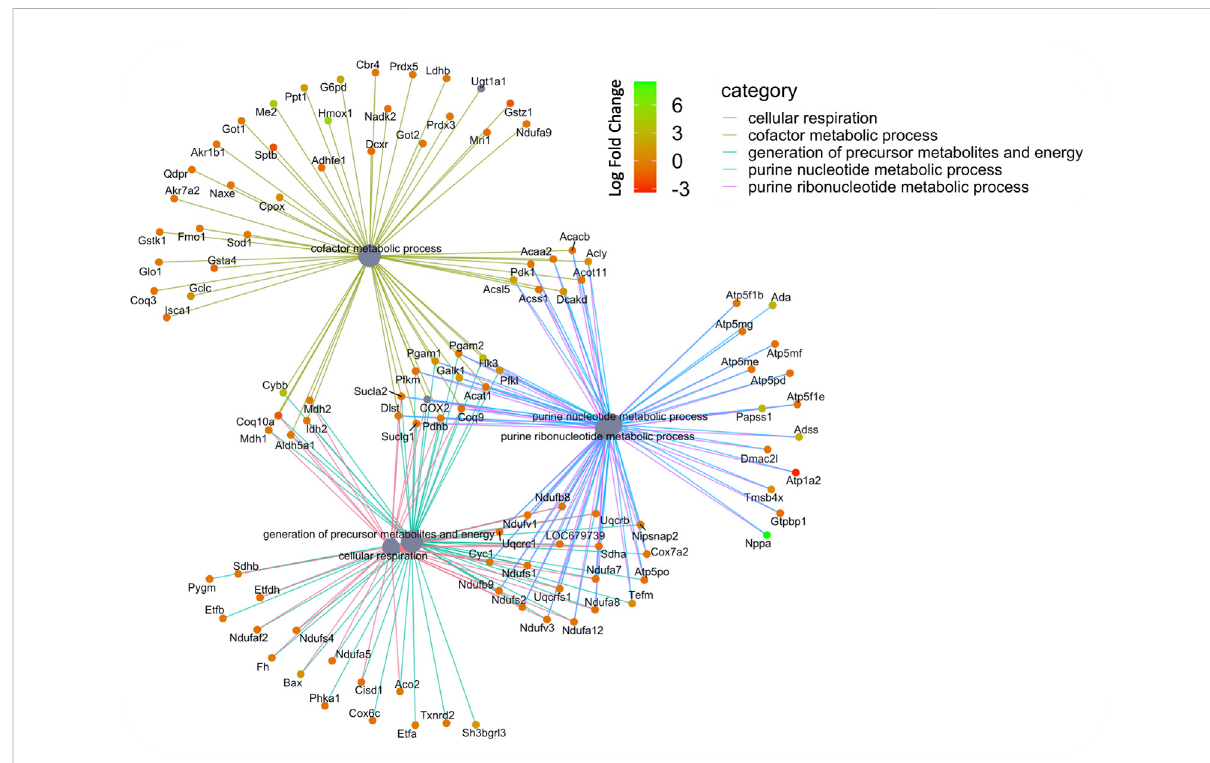
FIGURE 6 Network of GO enriched terms within the Molecular Function Domain. An enrichment of terms describing ‘ cellular respiration ’ and “ purine metabolism ” was resolved when we performed functional analysis on the 410 proteins that are also differentially regulated at the transcript